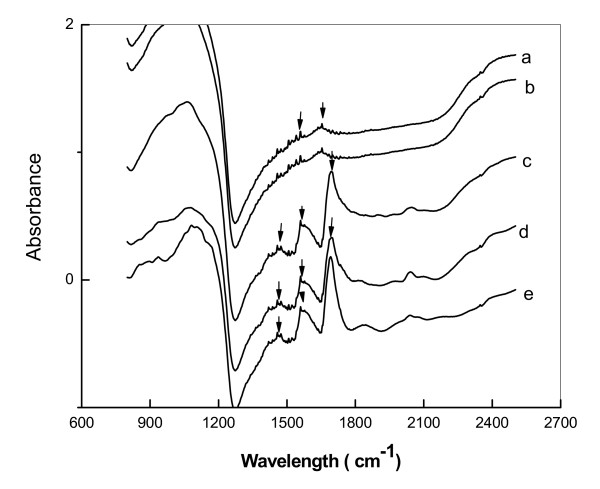
FTIR spectra of Fe3O4@Au (a), Fe3O4-LAA (b) huPrPrec (c), Fe3O4@Au-huPrPrec (d) Fe3O4-LAA-huPrPrec(e).